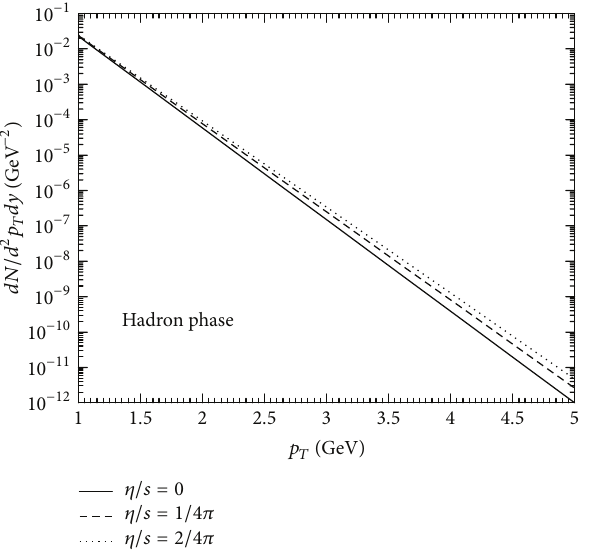
Figure 15: Transverse momentum distribution of thermal photons from the entire evolution history of the system for various values of 𝜂/𝑠 in the scenario (i).